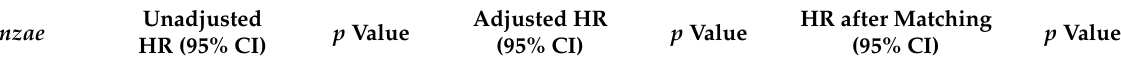
Table 3. Cox regression hazard estimates for risk of H. influenzae with use of inhaled corticosteroids in the study population (n= 21,218) and propensity score-matched population (n = 13,324).